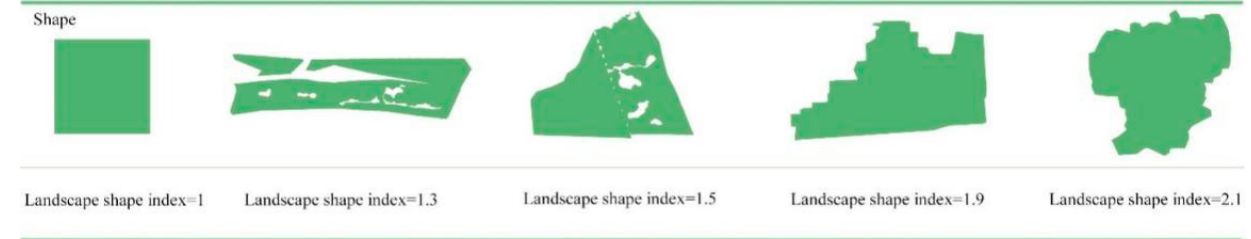
Figure 2. Landscape shapes with increasing LSI value.